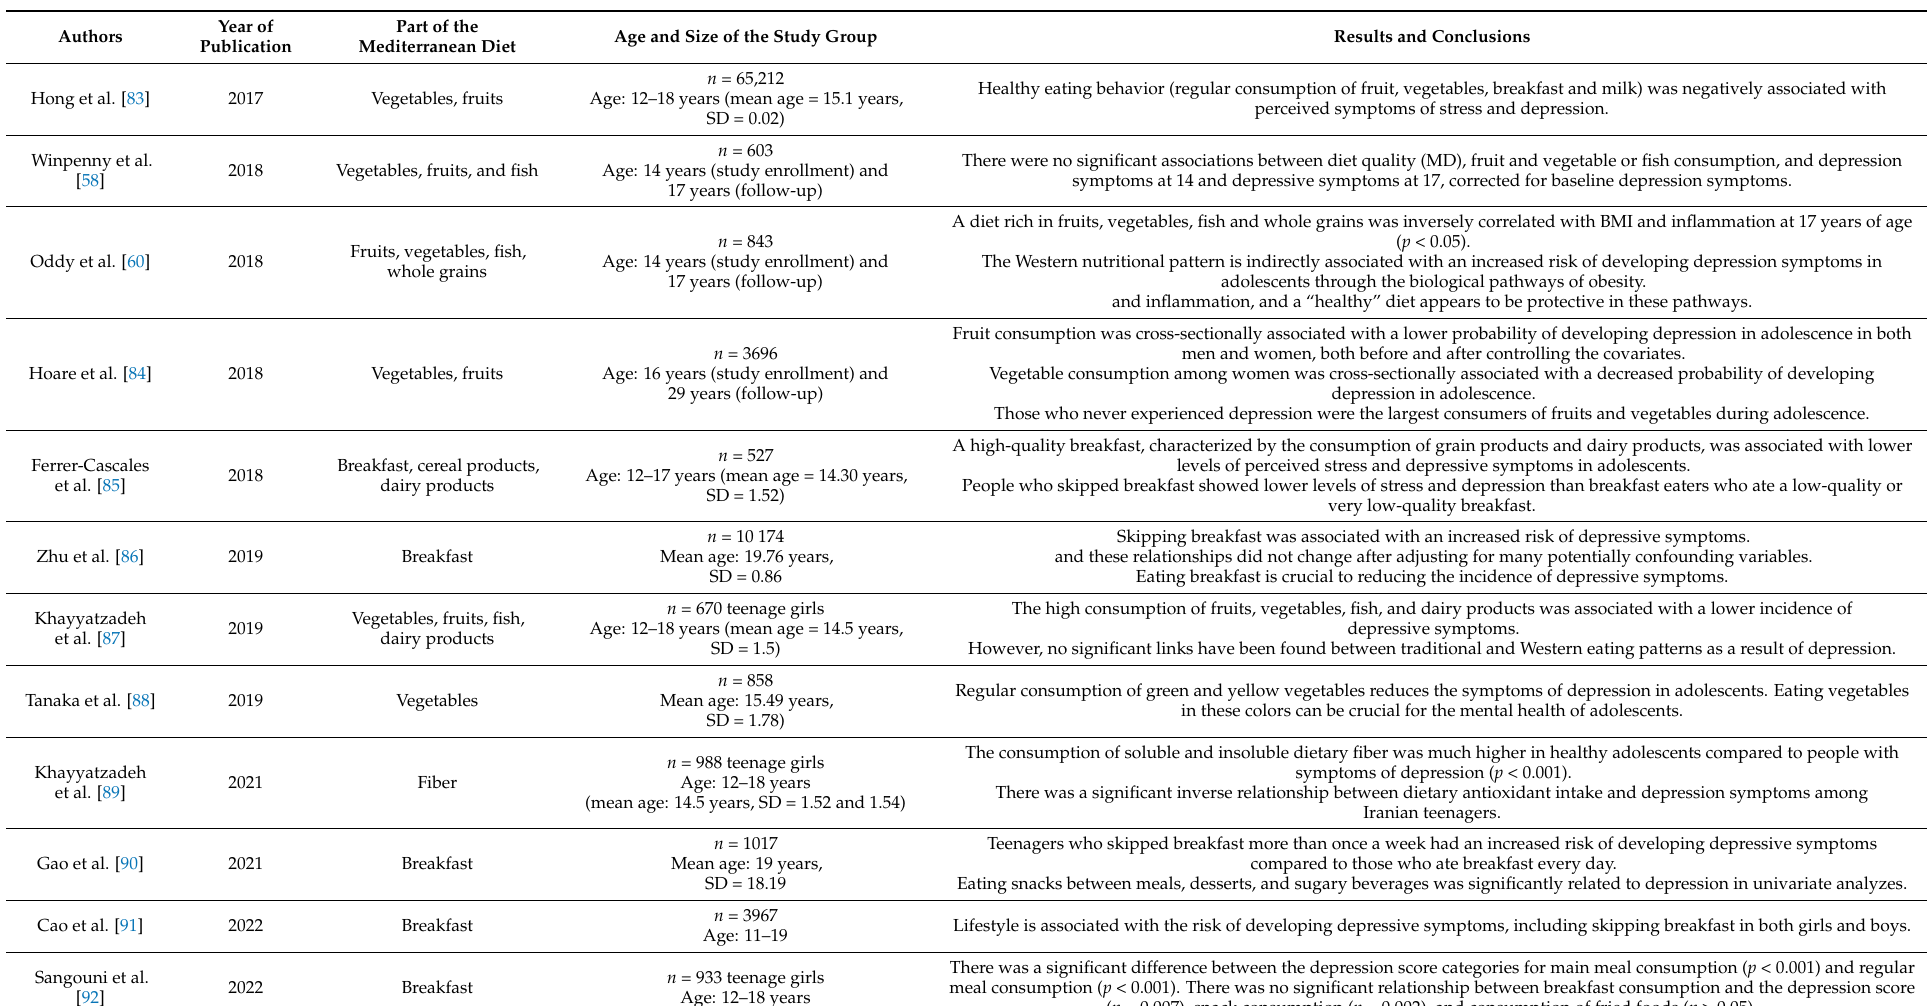
Table 1. Dietary behaviors in the context of the Mediterranean diet and their influence on depression in a study among